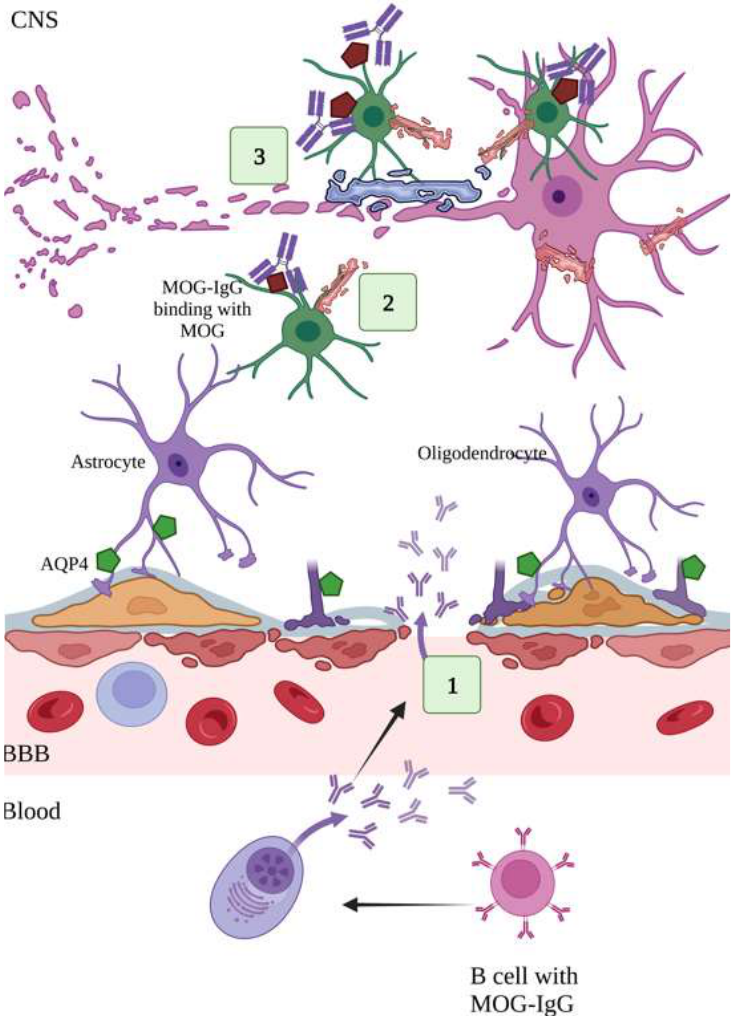
Figure 4. MOG-IgG dependent pathology. MOG-IgG antibodies are specific for myelin oligoden- drocyte glycoprotein present on the myelin-forming oligodendrocytes and myelin sheath, which insulates the neuronal cell. (1) The MOG-IgG antibodies produced by plasma cells cross the BBB. (2) MOG-IgG antibodies bind with MOG antigens. (3) Binding of MOG-IgG onto the MOG causes re- lease of myelin basic proteins, resulting in demyelination, oligodendrocyte damage, and loss of neu- ronal cells [129–131]. (Figure created using BioRender.com; accessed on 12 February 2023).